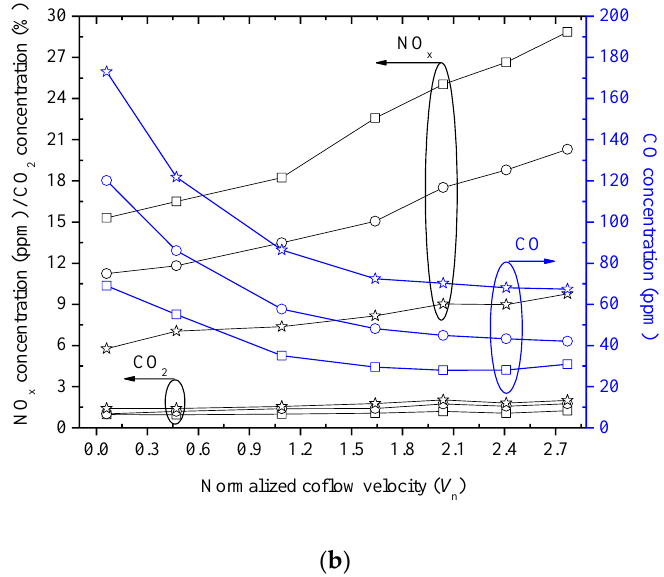
Figure 6. NO x /CO 2 /CO emissions versus N 2 -O 2 coaxial-flow velocity ( ☆ : β = 21%; О: β = 24%; □ : β = 27%).